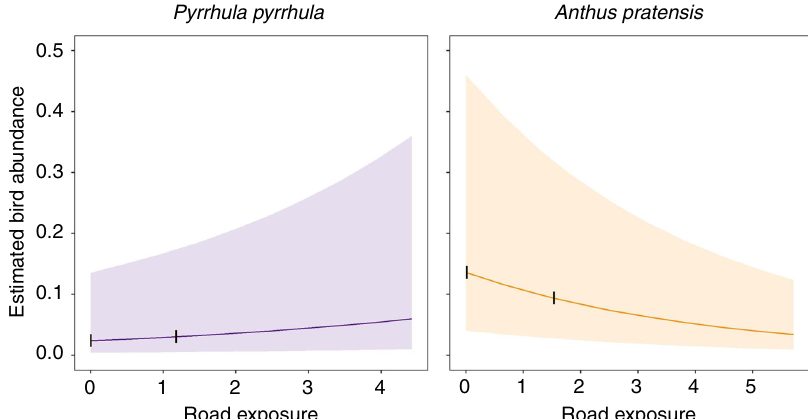
Fig. 4 Estimated abundance of two species across the full range of road exposure recorded for each. Bird abundance refers to the number of birds within 100 m of a 200-m BBS transect section. The 0.25 and 0.75 quartiles of road exposure for each species are indicated by the vertical lines, and 95% prediction intervals by the shaded areas. These graphs are available for all species in Supplementary Fig.